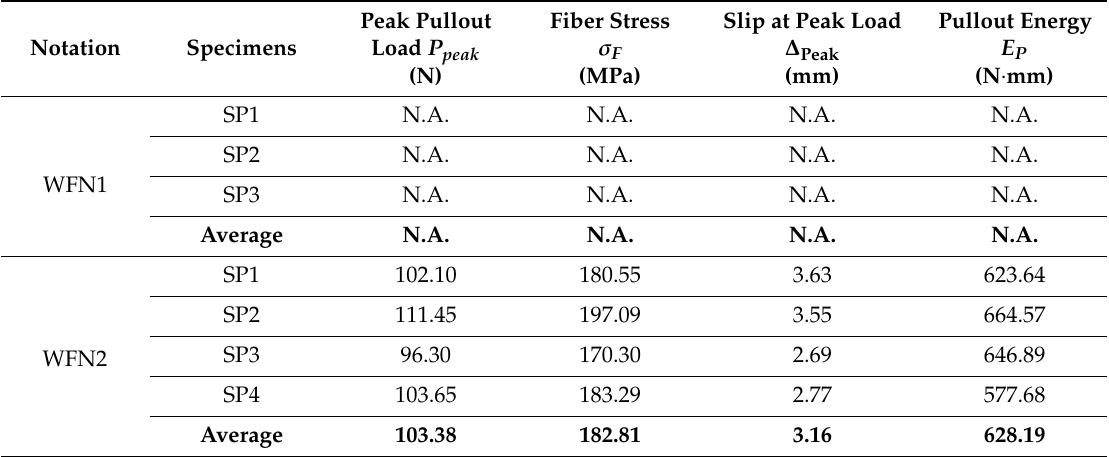
Table 3. Pullout test results.